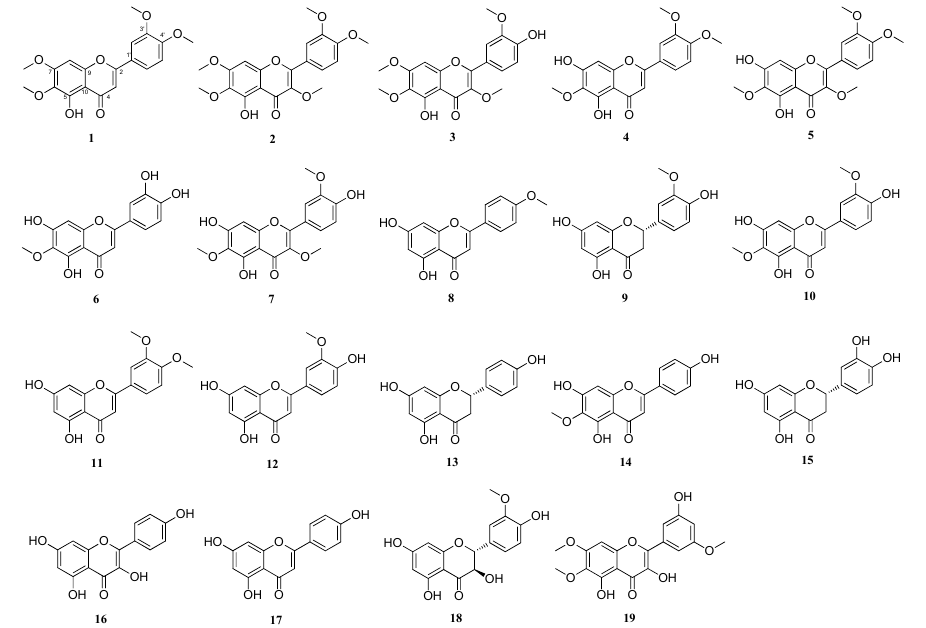
Figure 1. Structures of compounds 1 – 19 from Artemisia argyi : 3 ′ - O -methyl-eupatorin ( 1 ); artemetin ( 2 ); chrysosplenetin ( 3 ); eupatilin ( 4 ); bonanzin ( 5 ); eupafolin ( 6 ); 3,6,3 ′ -trimethoxy-5,7,4 ′ -trihydroxyflavone ( 7 ); acacetin ( 8 ); homoeriodictyol ( 9 ); jaceosidin ( 10 ); 3 ′ ,4 ′ -dimethoxyluteolin ( 11 ); 3 ′ -methoxyapigenin ( 12 ); naringenin ( 13 ); hispidulin ( 14 ); 5,7,3 ′ ,4-tetrahydroxyflavone ( 15 ); 3,4 ′ ,5,7-tetrahydroxyflavone ( 16 ); 5,7,4 ′ -trihydroxyflavone ( 17 ); 2,3-dihydroisorhamnetin ( 18 ); and apicin ( 19 ).